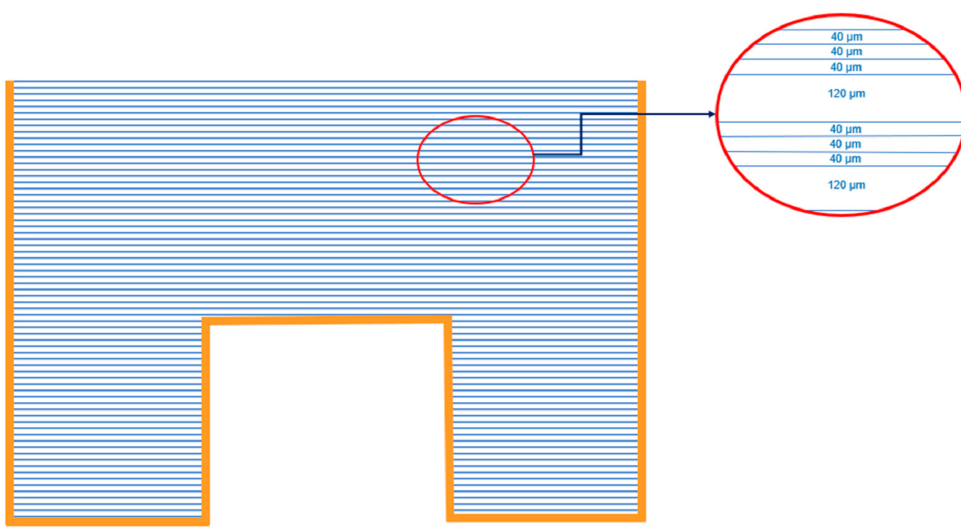
Figure 2. Placement of Makrofol N foils in 1 L Marinelli beaker for exposure in the environment. Above one 120 µ m foil, three 40 µ m foils are placed and this is repeated until the volume is filled. The exact solutions of Equation (1) have been obtained elsewhere [18,30].